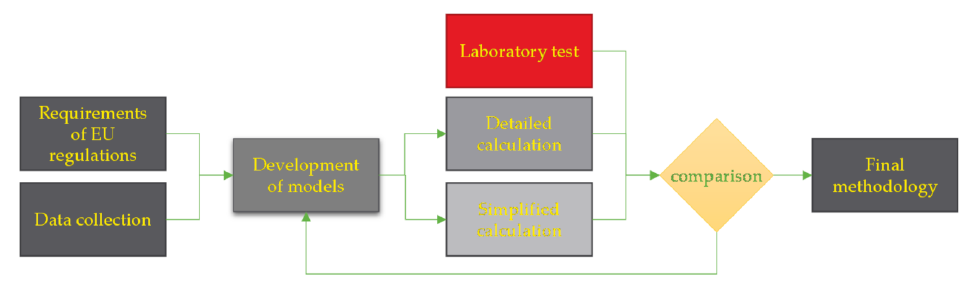
Figure 1. Development of the methodology for labeling existing